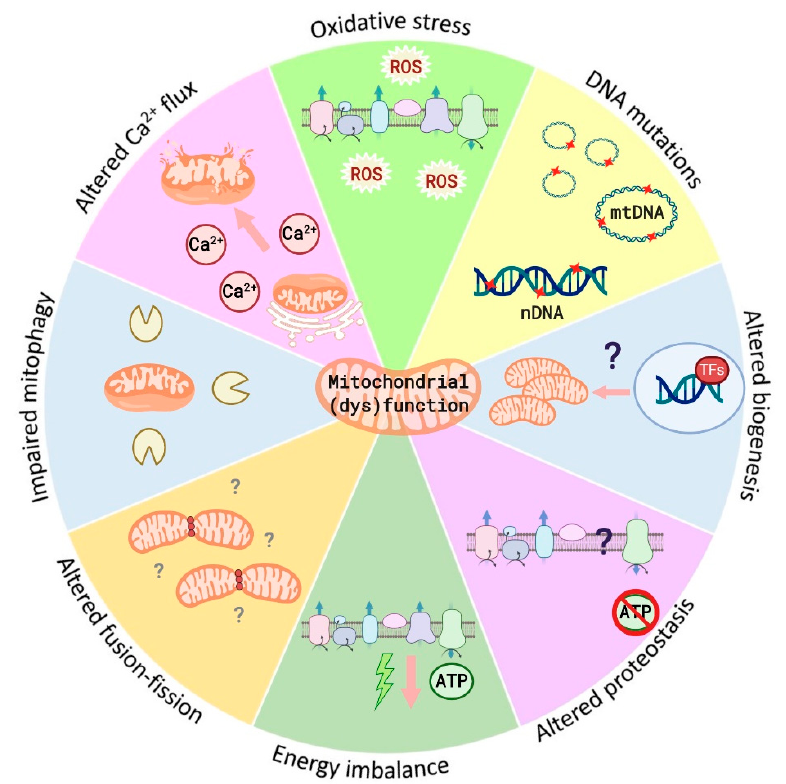
Figure 1. Mitochondrial (dys)function factors. Mitochondrial dysfunction is characterized by the combination of some of the processes described above and plays a central role in several diseases, such as metabolic syndrome. All these processes are closely related, usually affecting one each other and rarely having isolated effects. Oxidative stress leads to the accumulation of reactive oxygen species (ROS). In turn, high amount of ROS might trigger DNA mutations. Mitochondrial (dys)function can also be associated to reduced mitochondrial biogenesis through the decreased expression of mitochondrial genes. Moreover, altered proteostasis ( biogenesis, folding, trafficking, and degradation of mitochondrial proteins) is common. Another frequent consequence is an energy imbalance limiting the ATP supply. Furthermore, mitochondrial (dys)function may condition mitochondrial fusion-fission processes compromising mitochondrial renewal and material exchange. Similarly, impaired mitophagy triggers the accumulation of non-functional mitochondria. Finally, mitochondrial altered Ca 2+ flux and buffering , disrupt communication with other organelles such as endoplasmic reticulum and, in case of calcium release into the cytoplasm, the potential trigger of cell death.